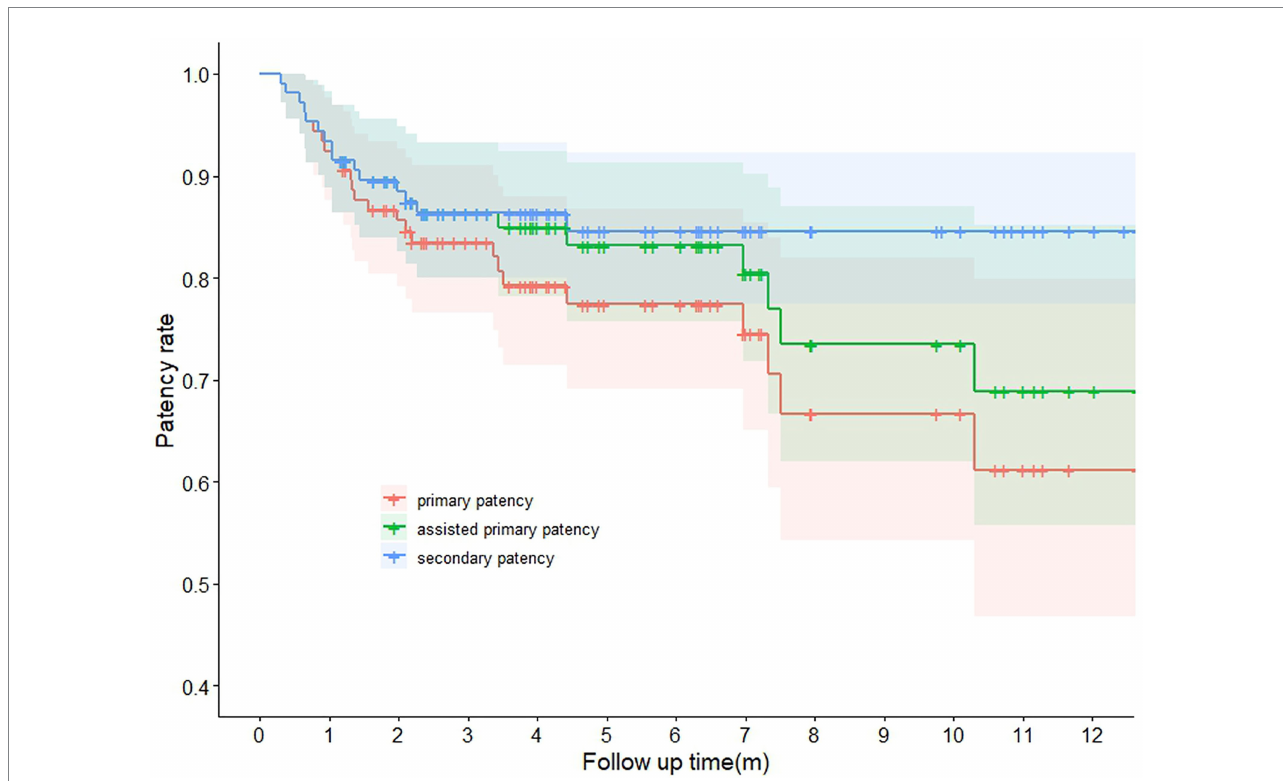
FIGURE 2 Postoperative patency rates of the 125 arteriovenous fistulas in long-term follow-up.